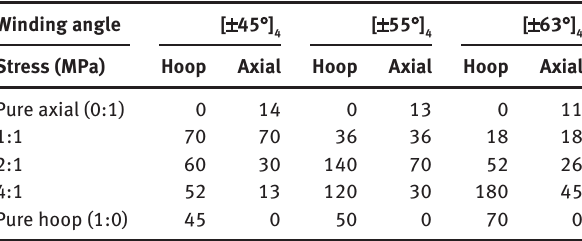
Table 1: Experimental results from the cyclic loading pressure test.